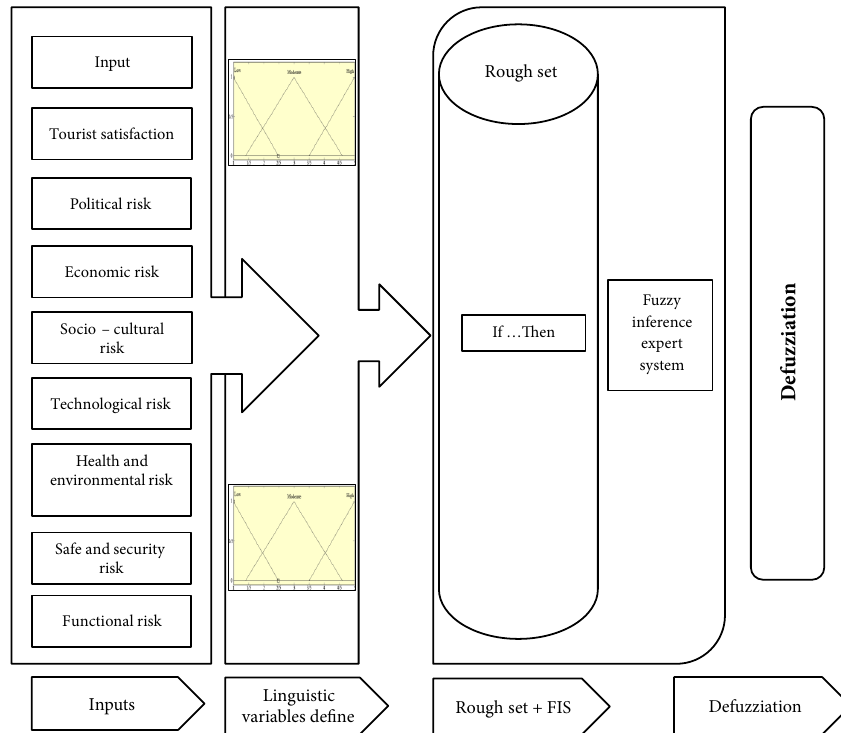
Fig. 6. Modeling and establishment of a system of knowledge risk-based